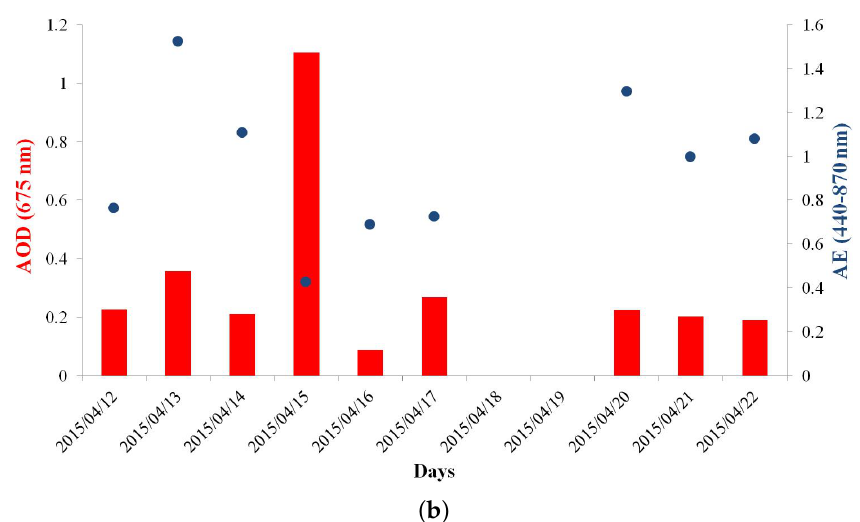
Figure 6. Diurnal ( a ) and daily ( b ) variations of AERONET AOD675 and Ångström exponent during dusty and non-dusty days. The red column represents AOD675, and the blue dot refers to Ångström exponent.